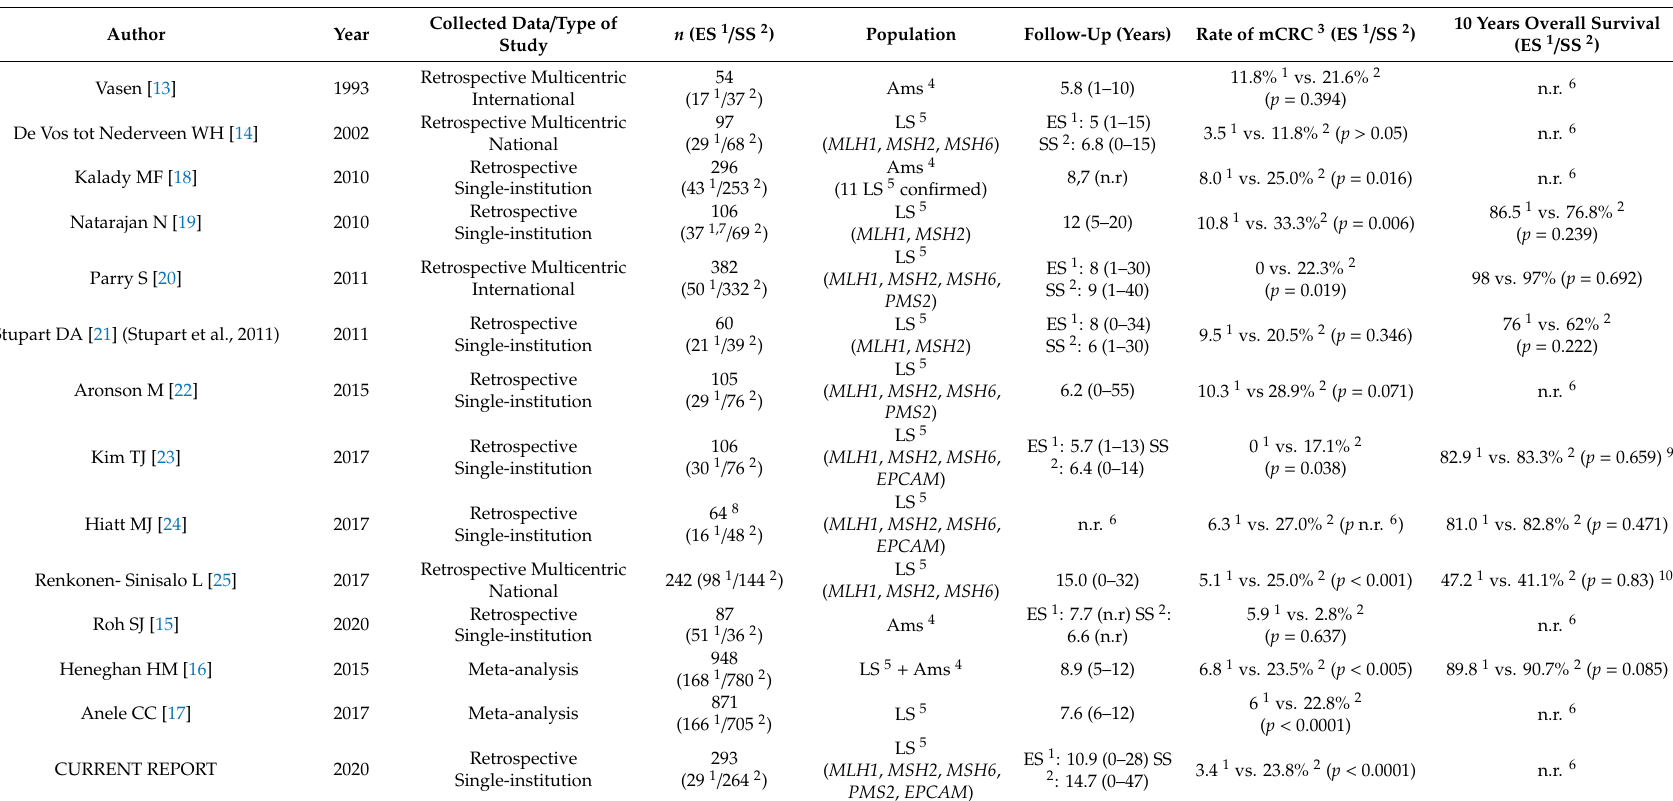
Table 6. Studies comparing colorectal cancer incidence and survival between extended surgery and segmental surgery in Lynch syndrome